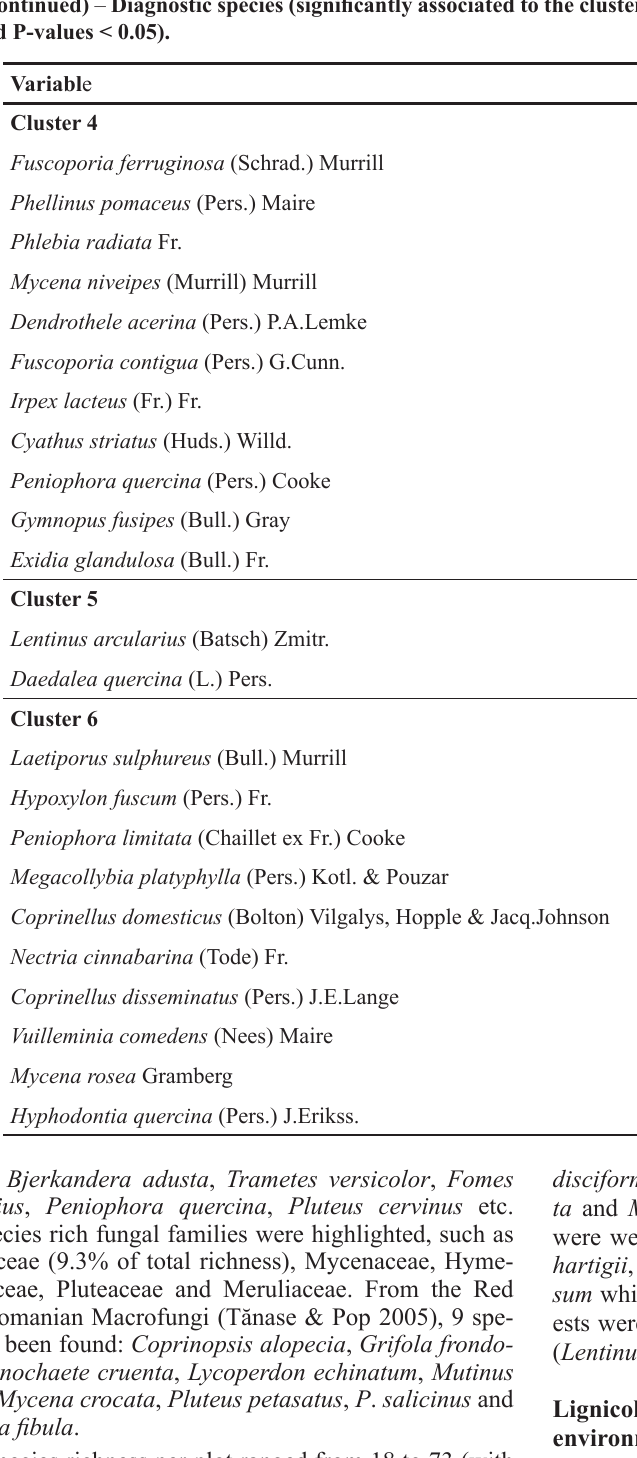
Hierarchical clustering algorithm generated a